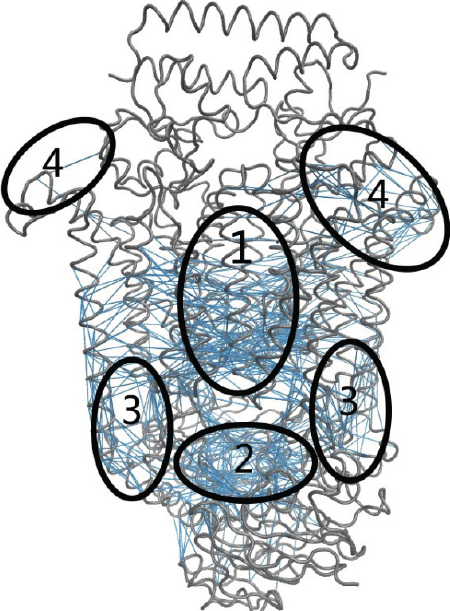
Figure 5. The functionally important residue interactions predicted by the perturbation method. The structure of BtuCD–BtuF is displayed in gray tube and the predicted key residue interactions are denoted by blue lines. According to their locations on protein structure, these key residue interactions are grouped into four regions that are denoted by ellipses and the numbers 1–4 in the